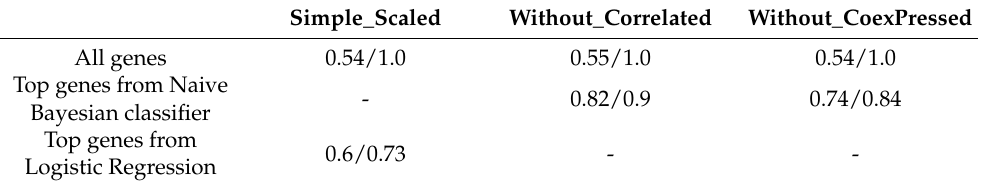
Table 2. Test/train cross-validation accuracies of SVM model, trained on all genes and genes selected by the iterative feature selection procedure with Naïve Bayesian classifier or Logistic Regression classifier. SVM model was applied to simple scaled (simple_scaled), without correlated genes (without_correlated), and without co-expressed genes (without_coexpressed) datasets. In contrast to all genes as a feature set, genes selected by the iterative procedure show predictive ability.